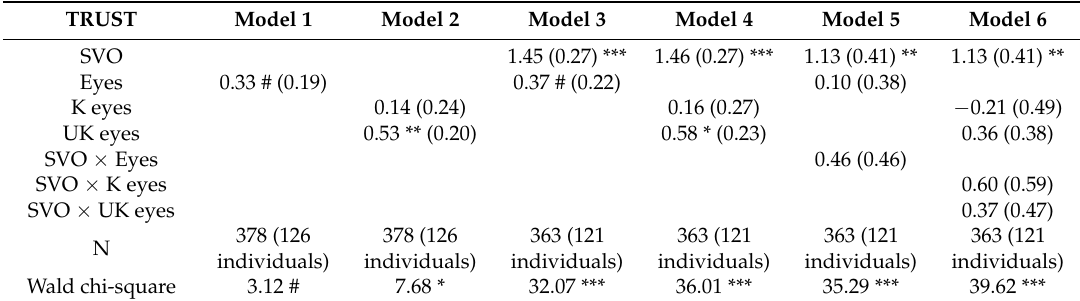
Table 1. Logistic regression estimates of the impact of SVO, kind eyes (K eyes) and unkind eyes (UK eyes) on first mover